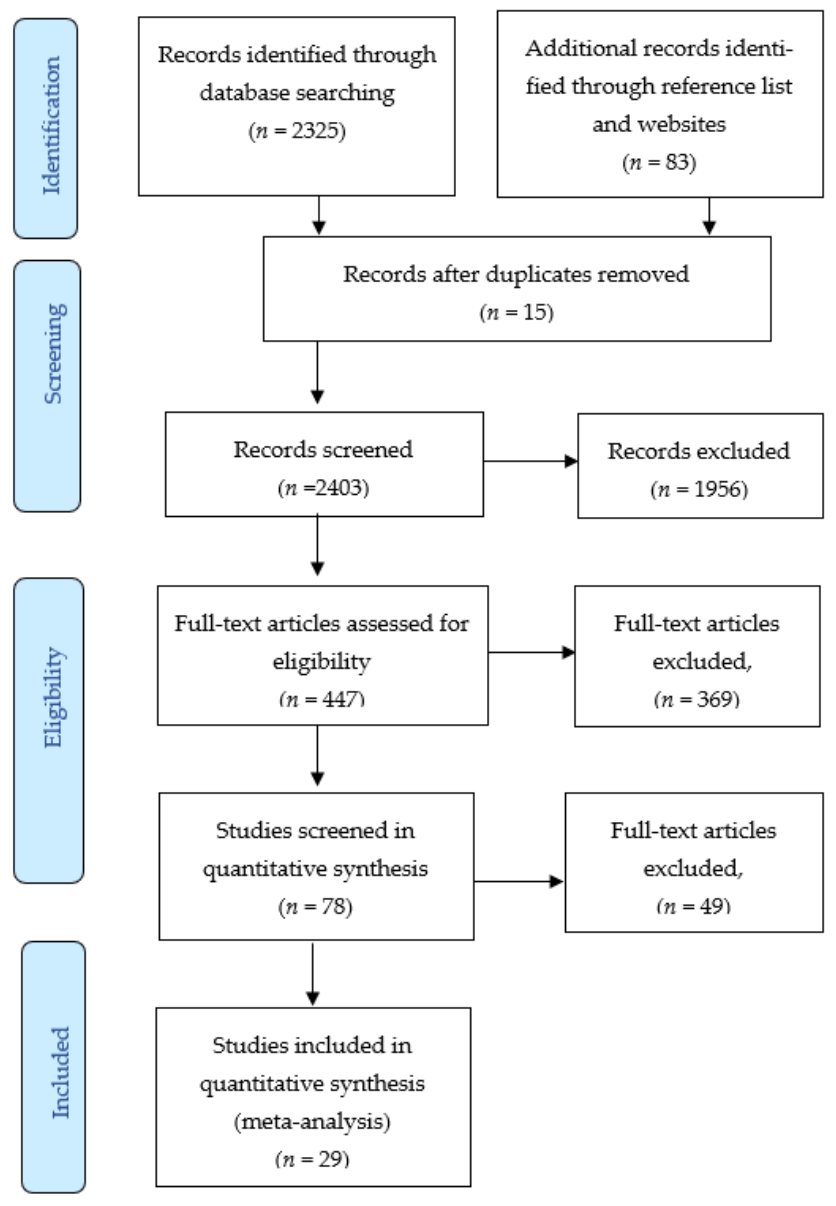
Figure 1. The Flow of Study Identification and Selection.